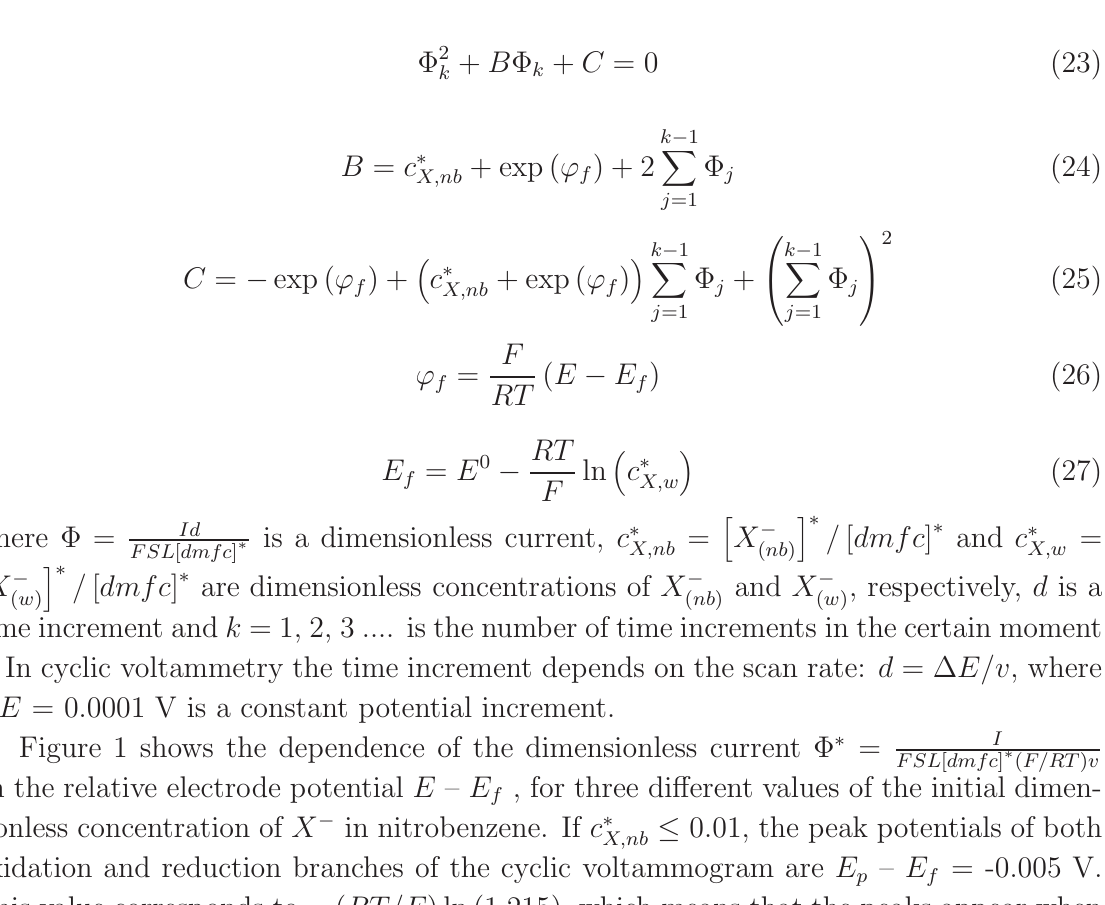
≥ 100, this relationship is linear, with the slope ∂E Fig. 2. If c ∗ X,nb